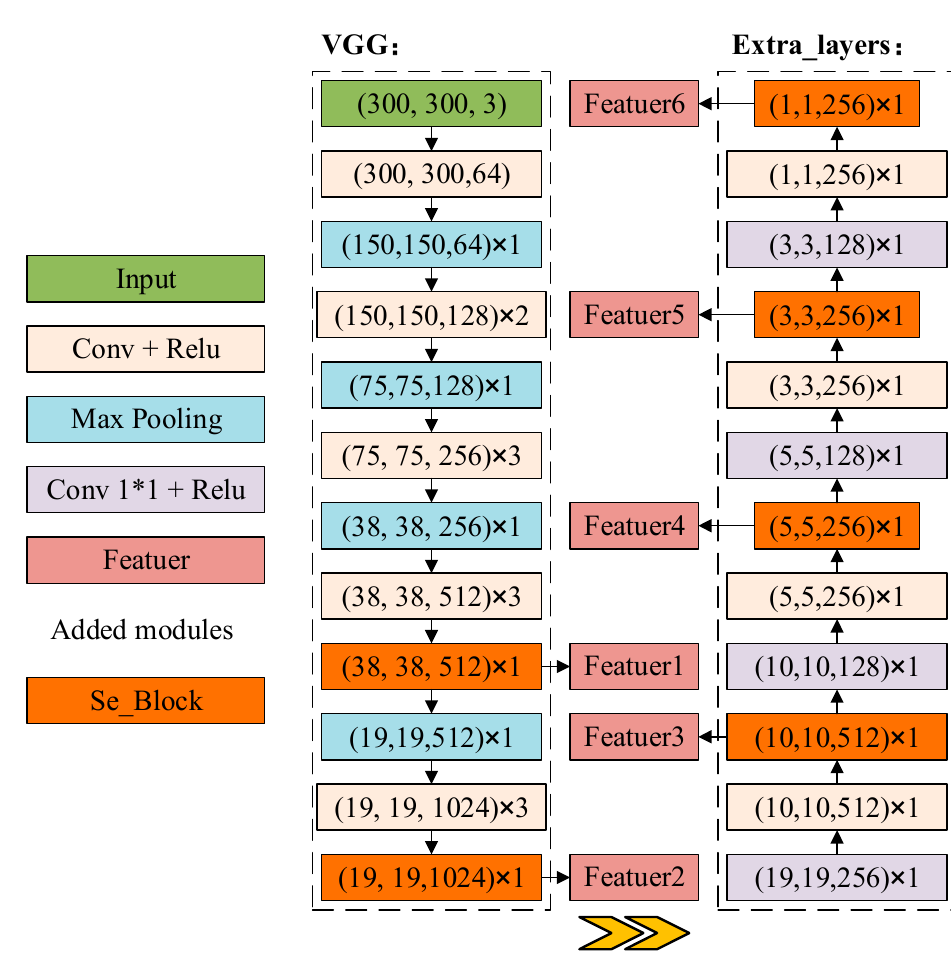
Figure 3. Se_SSD network structure.